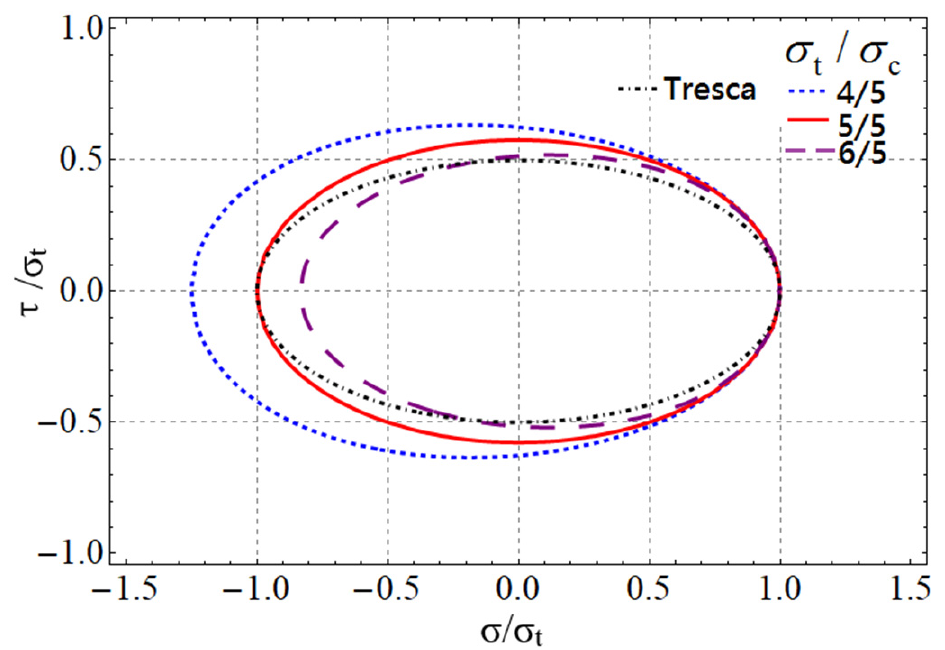
Figure 2. Yield loci predicted by the Tresca criterion and the isotropic yield criterion in the ( σ , τ ) plane for σ t / σ c = 4/5, 5/5 (von Mises) and 6/5, respectively. In order to take anisotropy into account, the criterion was extended by the orthotropic generalizations of the second and third invariant of the stress deviator, denoted by J 0